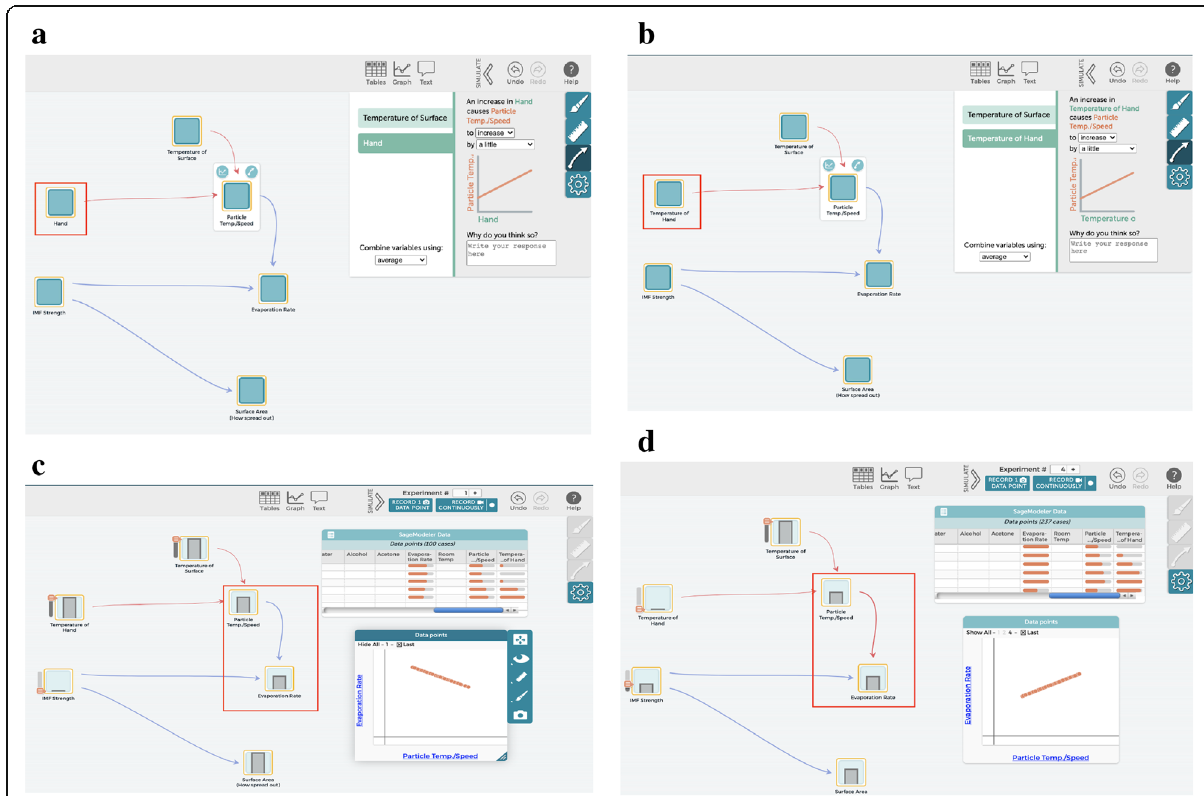
Fig. 7 Creating a computational model (creating artifacts) focusing on relationships among variables. a Building Relationship between variables. b Revise the name of elements to measurable variables. c Generation graphs through simulation. d Revise the relationships based on the generated